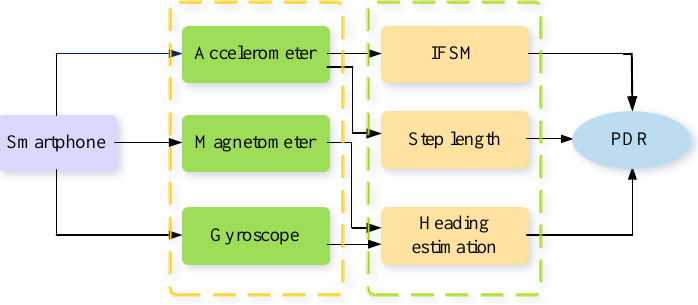
Figure 1. The flow chart of the PDR algorithm.